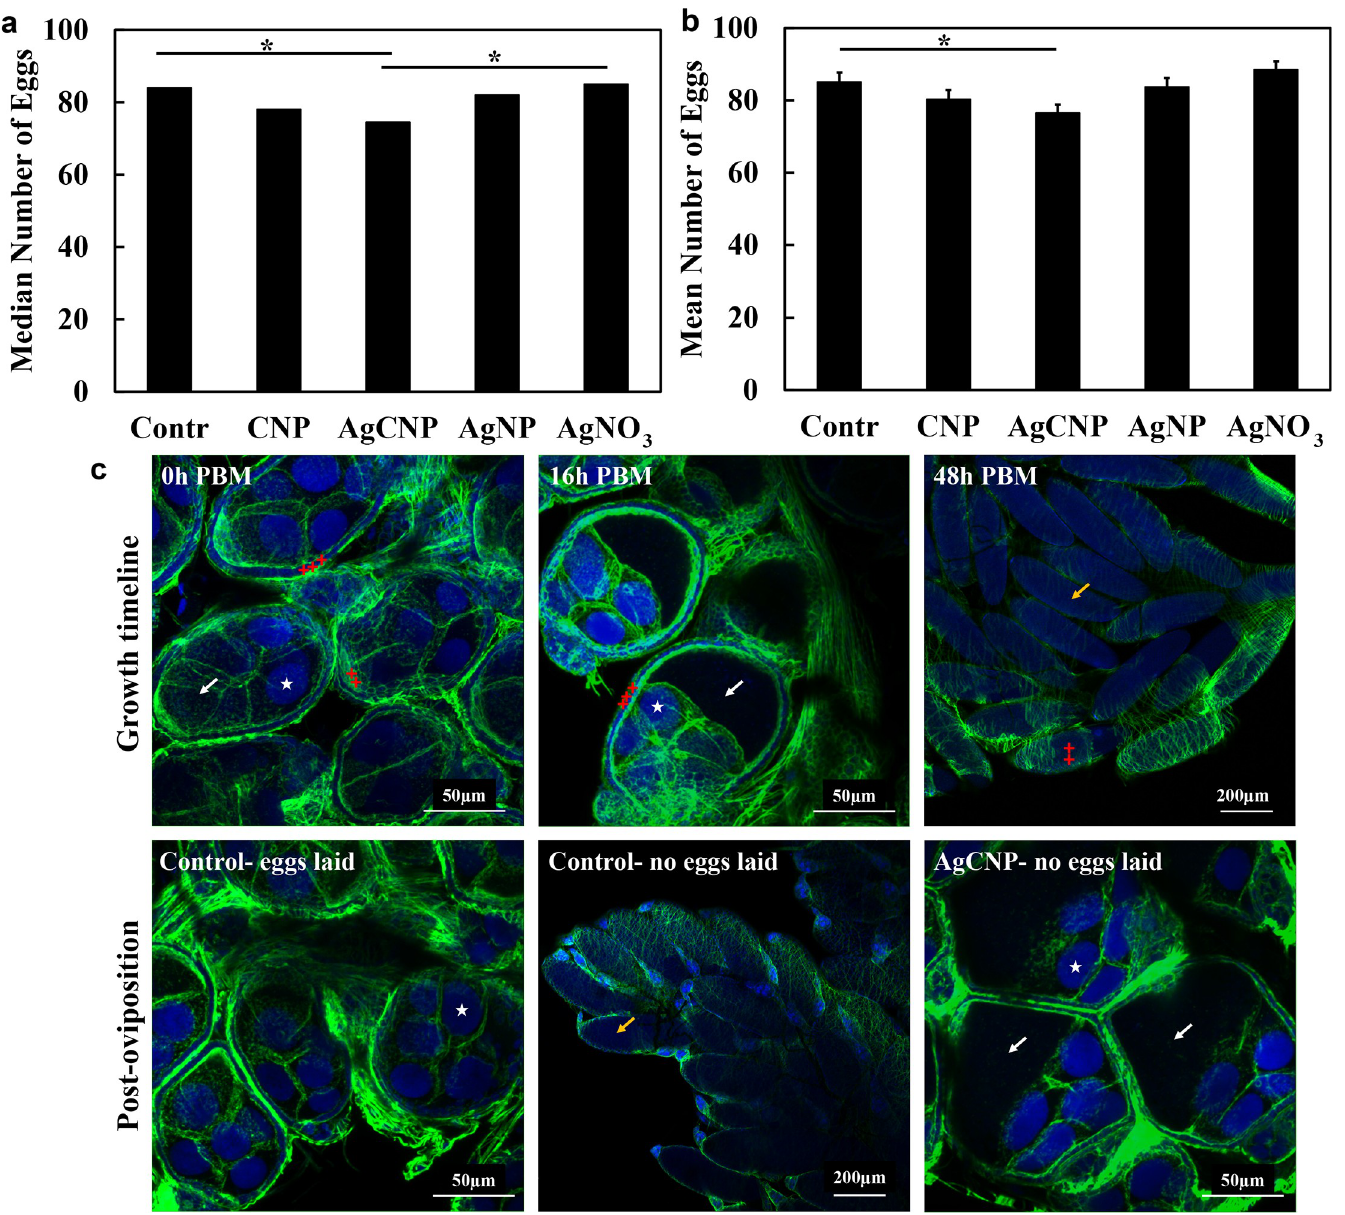
Fig 11. Effect of nanoceria exposure via blood meal on egg production of individual female Ae . aegypti . Nanoparticle-laced blood meals were fed to Ae . aegypti and well-fed mosquitoes were placed individually into separate oviposition cups. Egg clutches were counted and ovaries were imaged with confocal microscopy. ( a ) Median egg clutch sizes for individual mosquitoes; cups with zero (0) eggs were included in this graph and analysis. The median egg clutch of the AgCNP treatment group was significantly lower than those of the control and AgNO 3 groups (p-values < 0.05). ( b ) Mean egg clutch sizes for individual mosquitoes; cups with zero eggs were excluded from this graph and analysis. The mean egg clutch of the AgCNP-treated group was significantly lower compared to that of the control (p-value < 0.05). ( c ) Representative confocal images of dissected ovaries stained with NucBlue (blue) and ActinGreen 488 (green); excitation lasers: NucBlue channel– 405nm, ActinGreen 488 channel– 488nm. Z-stacks were processed and overlaid using ImageJ. The upper image series shows a typical egg growth timeline from 0 to 48h post-blood meal (PBM) for control mosquitoes. Ovarioles at 0h PBM (maximum intensity z-projection image) are in the pre-vitellogenic stage with barely discernible oocytes (white arrow). Oocytes start accumulating vitellogenin resulting in increased size (white arrow, 16h PBM, maximum intensity z-projection image) while the nurse cells (white stars) are polarized in the direction of secondary follicles. At 48h PBM, fully-grown eggs are seen in the ovaries (yellow arrow) ready to be oviposited. The follicular cells (red crosses) start shedding at this point. The lower left image shows representative 5-days post-oviposition ovarioles of a control mosquito (eggs laid), complete with secondary follicles having entered the pre-vitellogenic stage. The lower middle image shows fully-developed eggs retained in an ovary from a representative control mosquito that laid no eggs. A representative maximum intensity z-projection image of ovarioles from an AgCNP-exposed mosquito is presented in the lower right panel and shows oocytes (white arrows) with arrested growth that appear similar in size to control ovarioles at approximately the 16h PBM timepoint. � : p-value < 0.05. Solid lines indicate significantly different comparisons between median egg clutches in ( a ) and mean egg clutches in ( b ) in different treatment groups. Error bars in ( b ) = SEM. The experiment was repeated three (3) times, each with 25–30 cups of individual mosquitoes, yielding 83–90 cups in total for each experimental condition.